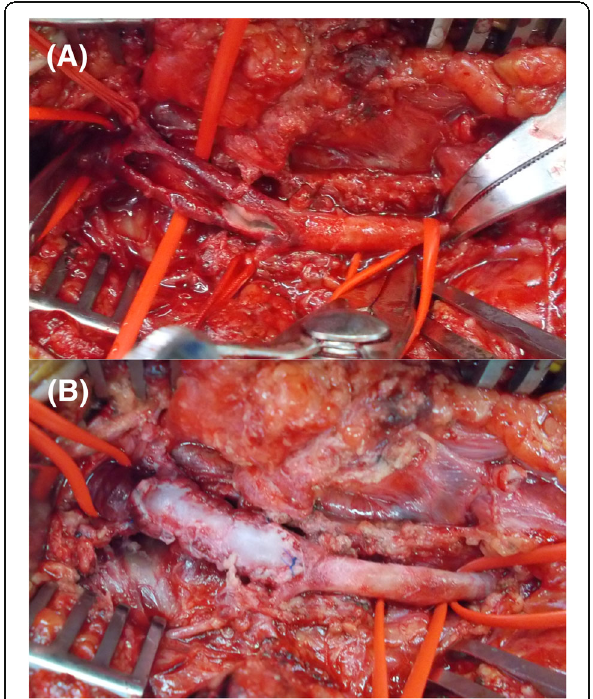
Fig. 2 Intraoperative findings show that a the intima of the injured part almost disappeared and the dissected intima barely remained on the proximal and distal sides of the CFA. b The repair of the CFA was performed with a saphenous vein patch. CFA, common femoral